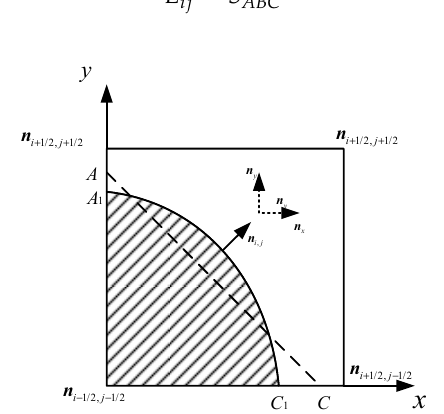
Figure 2. PLIC interface reconfiguration principle.